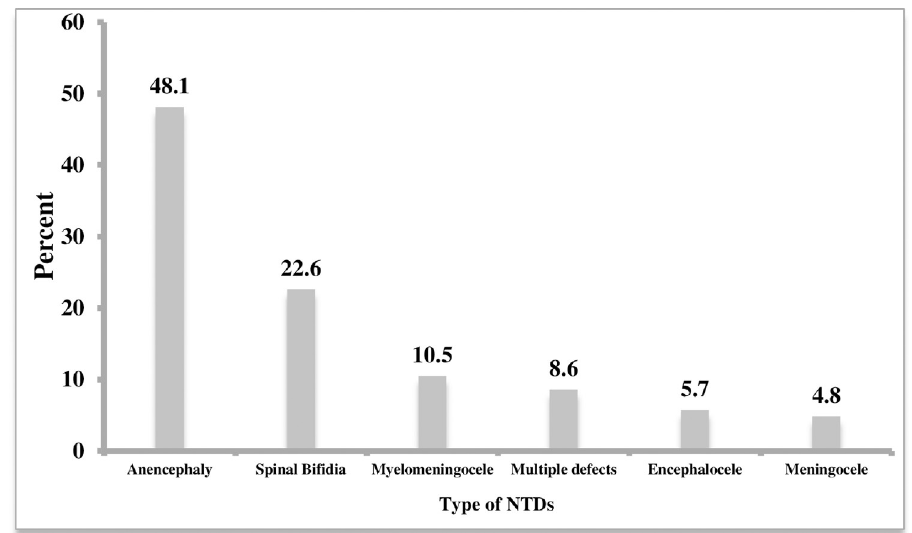
Fig 2. Type of identified NTDs in Eastern Ethiopia, data from September